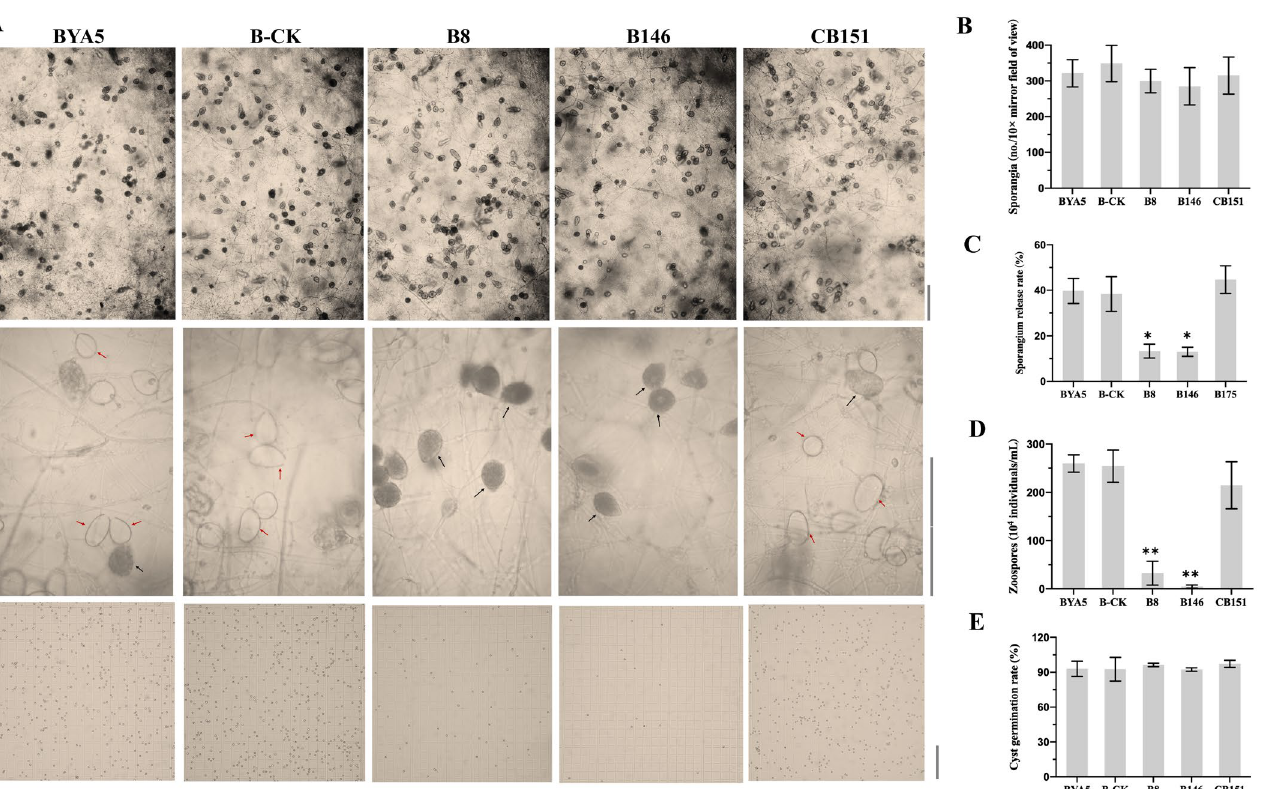
Figure 5. Effects of PcSTT3B on sporangia and zoospores in P. capsici . ( A ) Microscopic observation of sporangia, sporangial release, and zoospores. Red solid line arrows represent released sporangia . Black solid line arrows represent unreleased sporangia . Bar = 100 µm. ( B ) Sporangium production observed at 10× mirror magnification power. ( C ) Sporangial release rates of different strains. Spo- rangial release rate = the number of released sporangia / (the number of released sporangia + the number of unreleased sporangia). ( D ) Zoospores examined with a hemocytometer. ( E ) Cyst germi- nation rates of different strains. Data represent the mean ± standard deviations from three biological repeats. Asterisks indicate significant differences from the Wild type BYA5 strain (*, p < 0.05; **, p < 0.01).